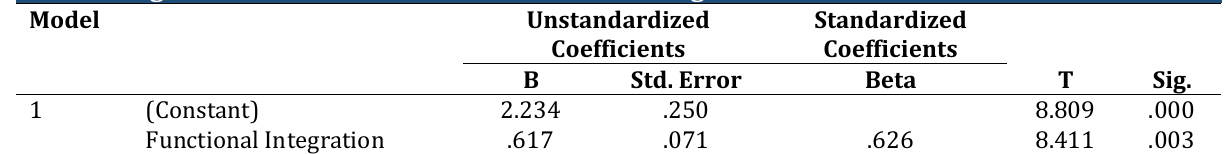
Table 6: Significance of test results for functional integration